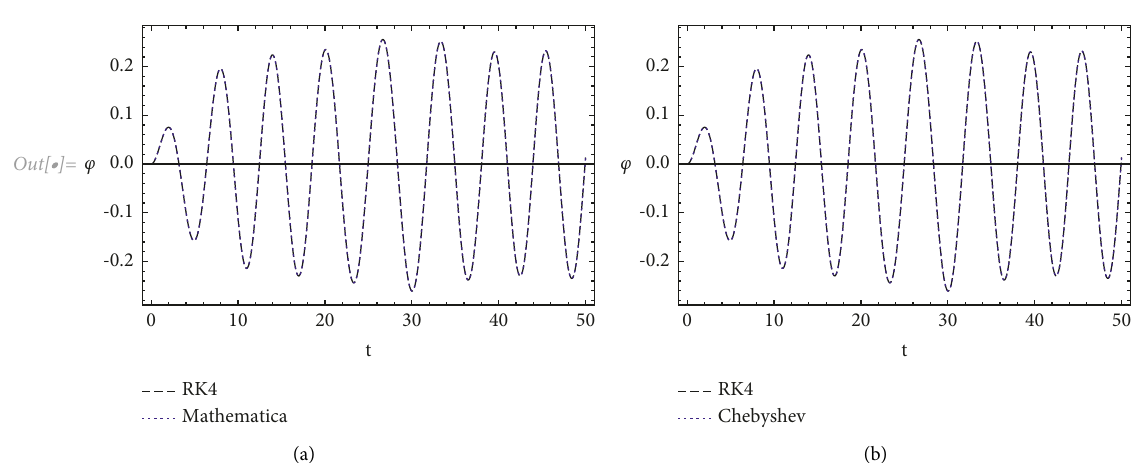
Figure 2: The comparison between the approximations of i.v.p. (3) using RK numerical solution with MATHEMATICA command Fit (here, polynomial (25)) and Chebyshev collocation numerical solution (24) for n (cid:28)